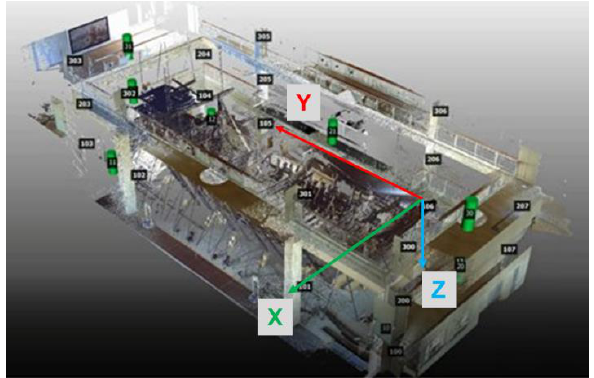
Figure 8. Ground control network and Bremen Cog (Scan visualisation)